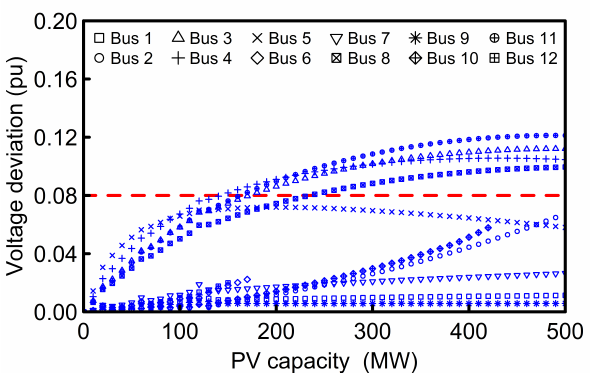
Figure 14. Maximum bus voltage deviation for defined PV capacity. A violation is recorded if the maximum voltage deviation exceeds 0.08 pu. The maximum voltage deviation is also an indicator of the expected voltage variation due PV